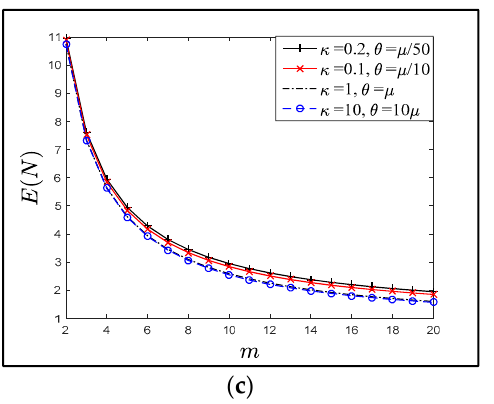
Figure 6. Effect of SAPs on the expected LAPs when the residence time is distributed as in ( a – c ). ( a ) Exponentially distributed residence time with mean µ − 1 . ( b ) Hypo exponential distributed residence time with mean μ − 1 + µ − 1 . ( c ) Gamma distributed residence time, when λ = 20 µ . On the other hand, the function Ψ ( n , m ) had a different behavior with respect to m , for the fixed ratio γ . Figure 7a–f plot the probability density function Ψ ( n , m ) when the number of SAPs was 5 ≤ m ≤ 20, for various residence-time distributions. Notice that the behavior of Ψ ( n , m ) was similar after a specified number of n ; for n ≥ 6, the plotted points were closed to each other. This observation was consistent with Figure 6, i.e., the E ( N ) value was the same for the large ( m ) value, and the increasing value of m did not improve the E ( N ) value.